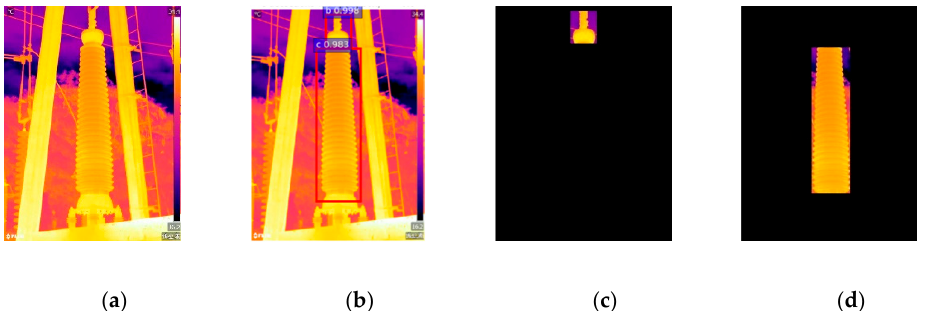
Figure 8. Results of eliminating the interference information in the image of termination: ( a ) original infrared image; ( b ) detecting results of Faster RCNN network; ( c ) extracting result of the connection fitting; ( d ) extracting result of the sleeve.